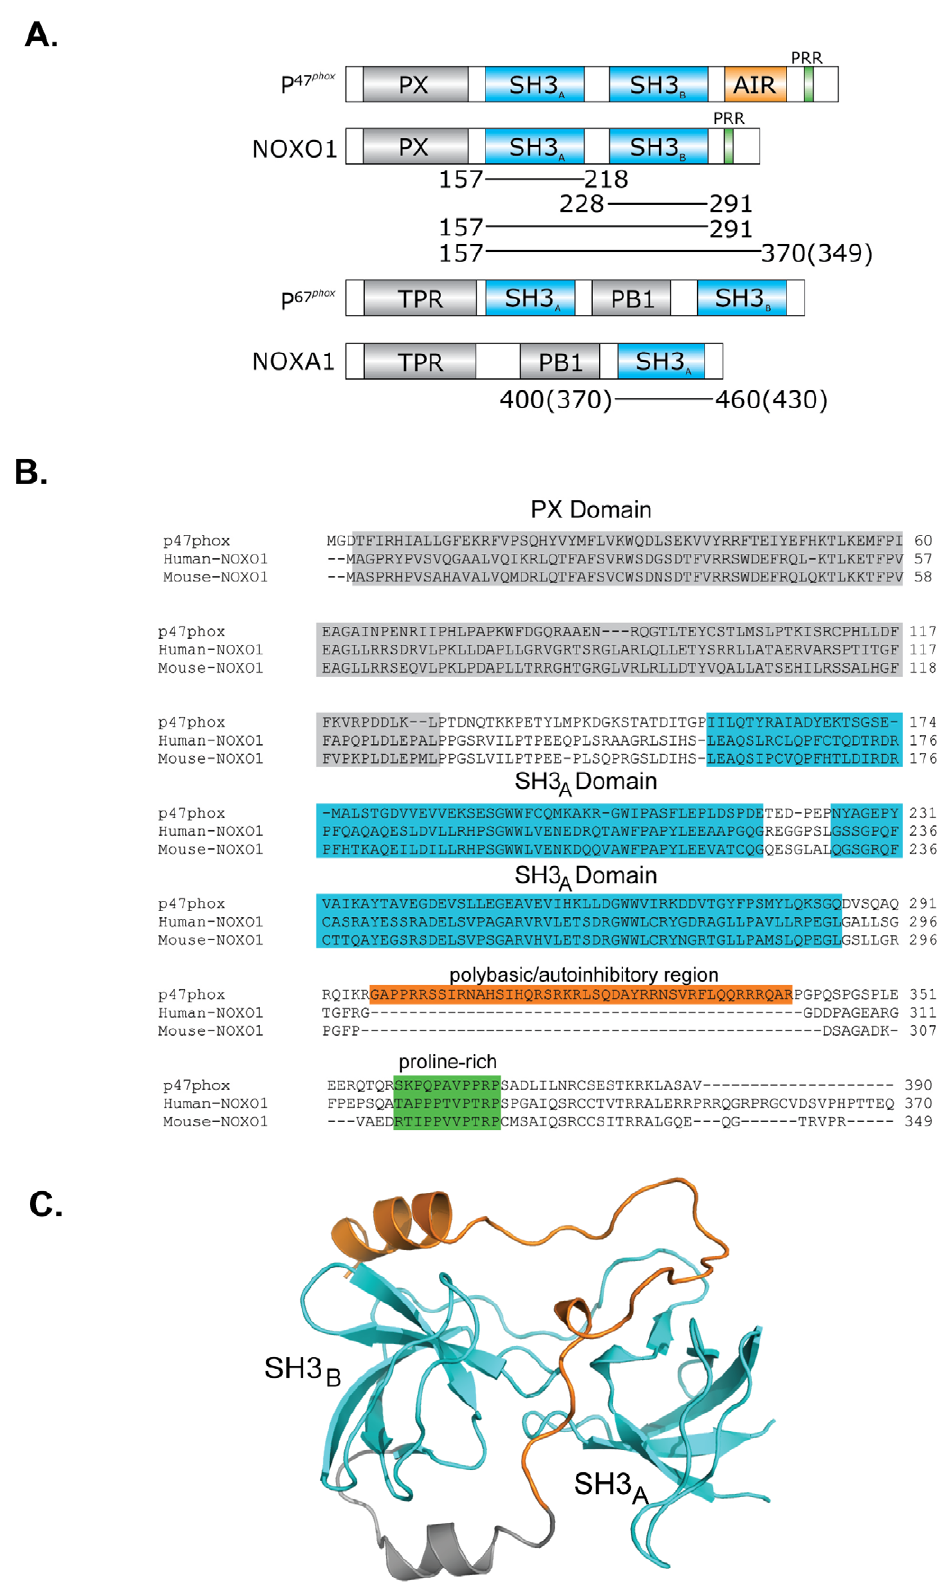
Figure 1. Schematic representation of the domain structures of p47 phox , NOXO1, p67 phox and NOXA1. ( A ) Predicted domain structures of NOXO1 and NOXA1 in comparison to p47 phox and p67 phox , respectively. Human and mouse constructs used in this study are illustrated by black lines. Mouse constructs are identical in length unless otherwise stated in brackets. The autoinhibitory region (AIR) and proline rich region (PPR) are